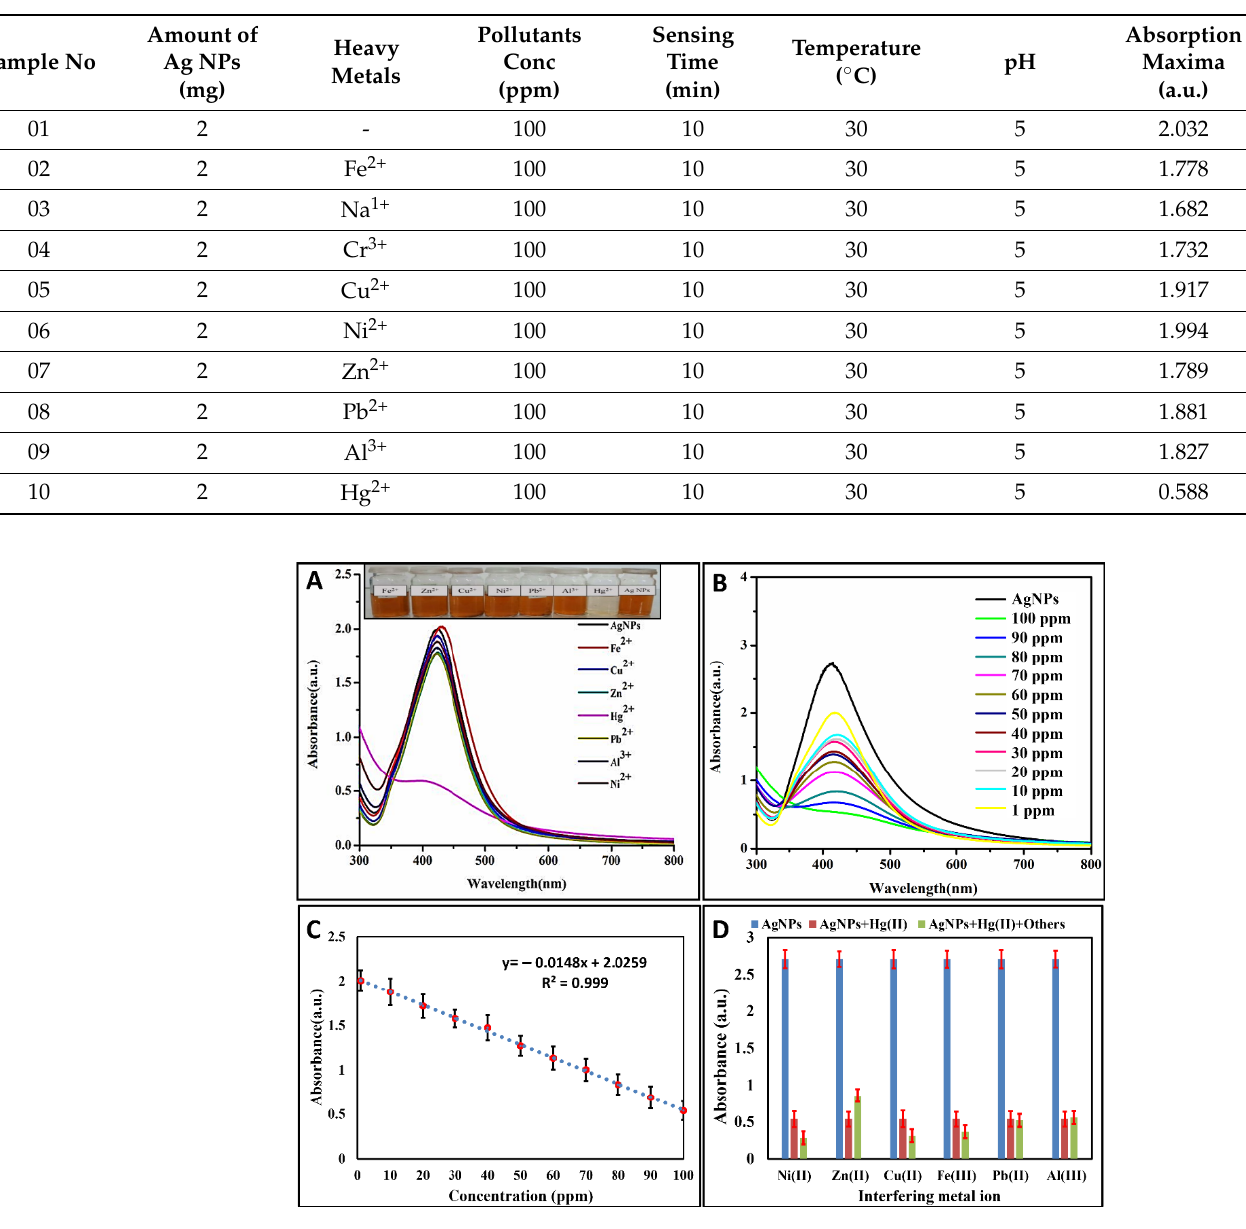
Figure 4. ( A ) Photographs and UV absorption spectra of AgNPs dispersions containing 100 ppm